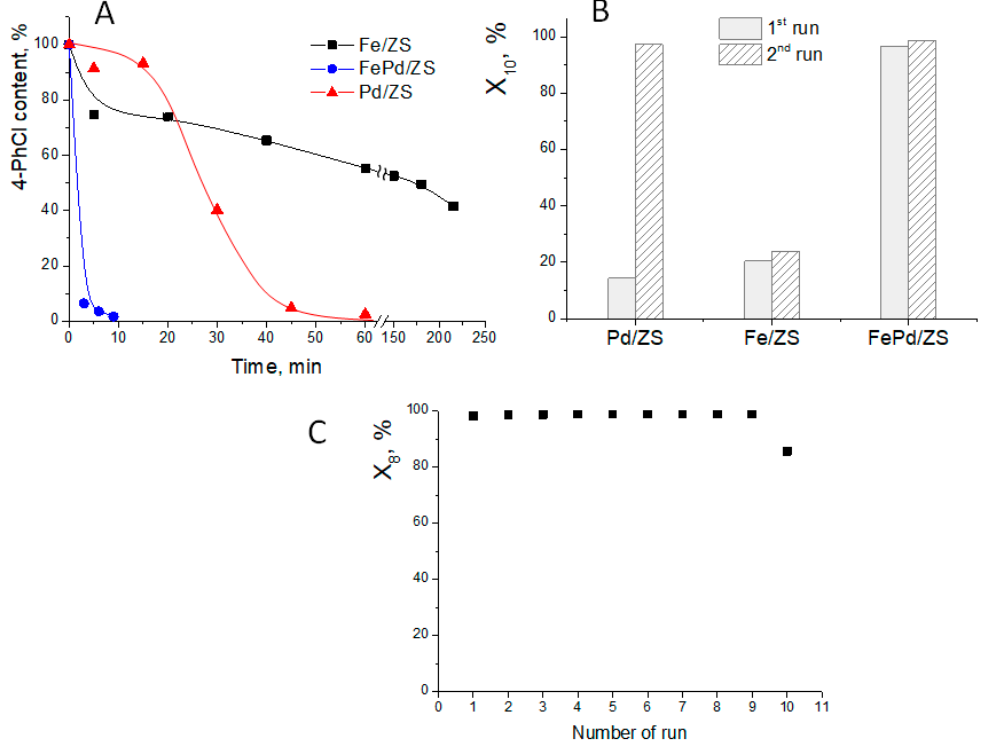
Figure 8. 4-PhCl content in the reaction mixture vs. reaction time over the catalyst reduced with NaBH 4 +H 2 ( A ); conversion of 4-PhCl after 10 min of the reaction (X 10 ) in the first and second runs ( B ); 4-PhCl conversion after 8 min (X 8 ) in 10 consecutive cycles over FePd/ZS reduced with H 2 in water at 30 °C ( C ). Reaction conditions: T = 30 ◦ C, m cat = 0.1 g, V 4-PhCl = 0.015 L, C 0 4-PhCl = 75 mg/L (0.8 mmol/L), pH = 7, V H2 = 0.6 L/h.